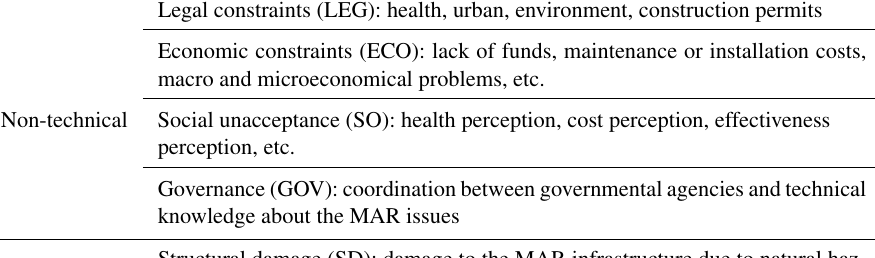
Table 1. Events of the fault tree divided by categories for non-technical and technical issues. Legal constraints (LEG): health, urban, environment, construction permits Economic constraints (ECO): lack of funds, maintenance or installation costs, macro and microeconomical problems, etc. perception,